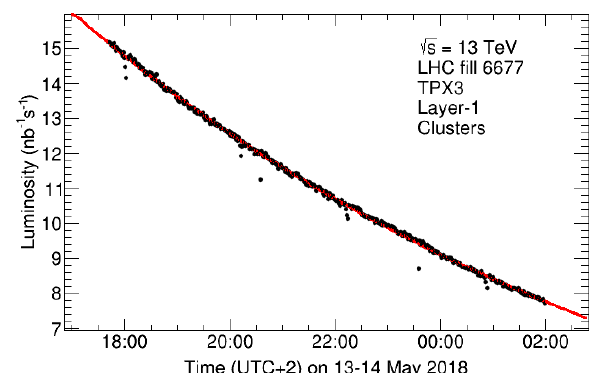
Figure 61. Time history of the LHC luminosity, as seen by TPX3 layer 1 using cluster-counting in LHC Run 6677. The small dips, visible as variations from the descending curve, correspond to the times when the LHC operators performed small-amplitude beam-separation scans to optimize or increase the luminosity. The solid line shows the fit to the data by the function given in Equation (2). Taken from Ref. [18].